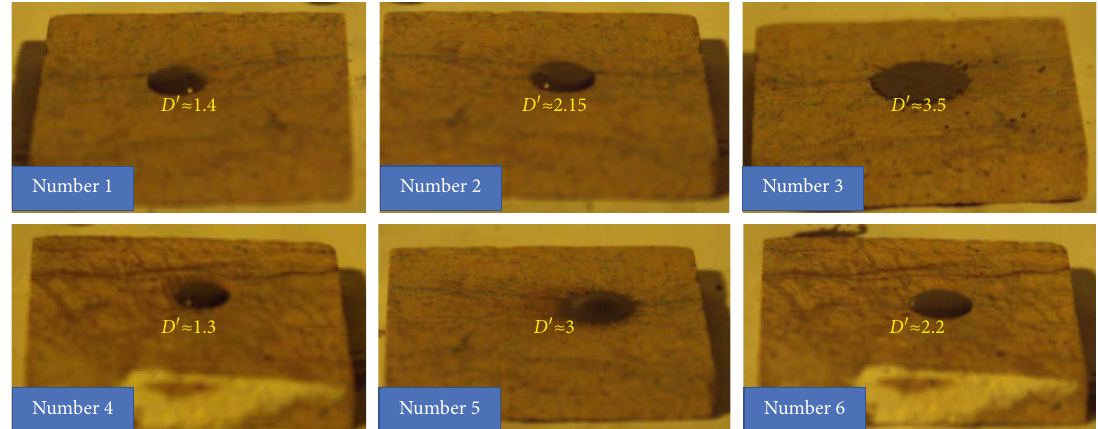
Figure 10: Droplet spreading after striking the substrate of the test apparatus. Table 5: Experimental verification of spreading